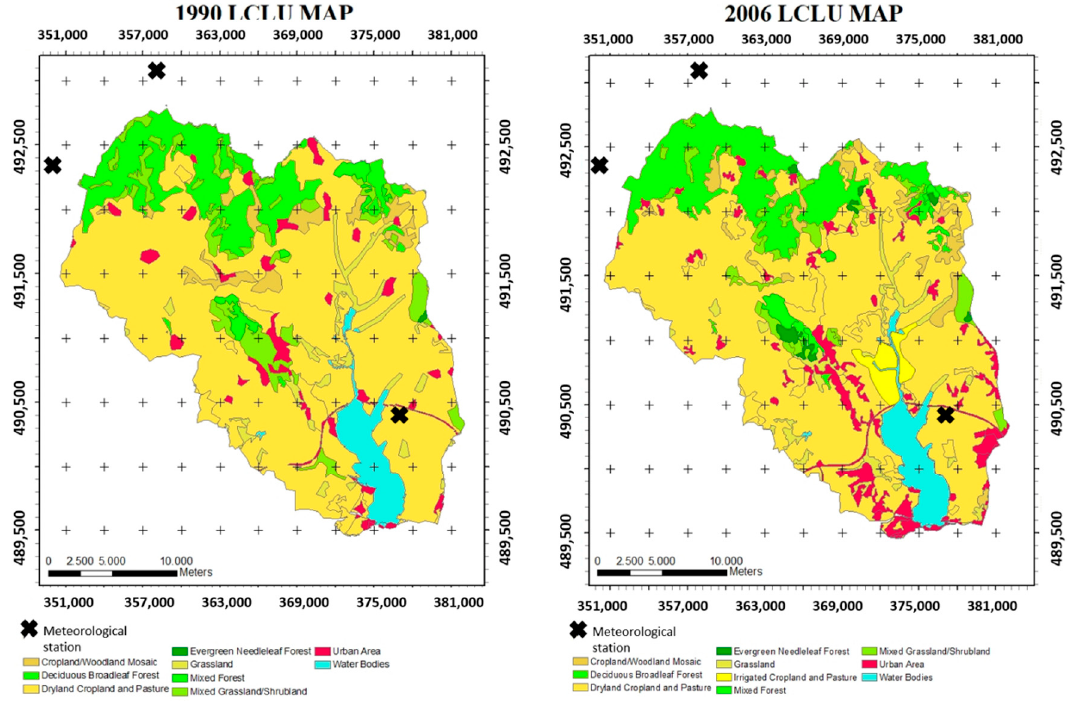
Figure 2. The 1990 and 2006 LCLU maps of the study area and locations of the meteorological stations.